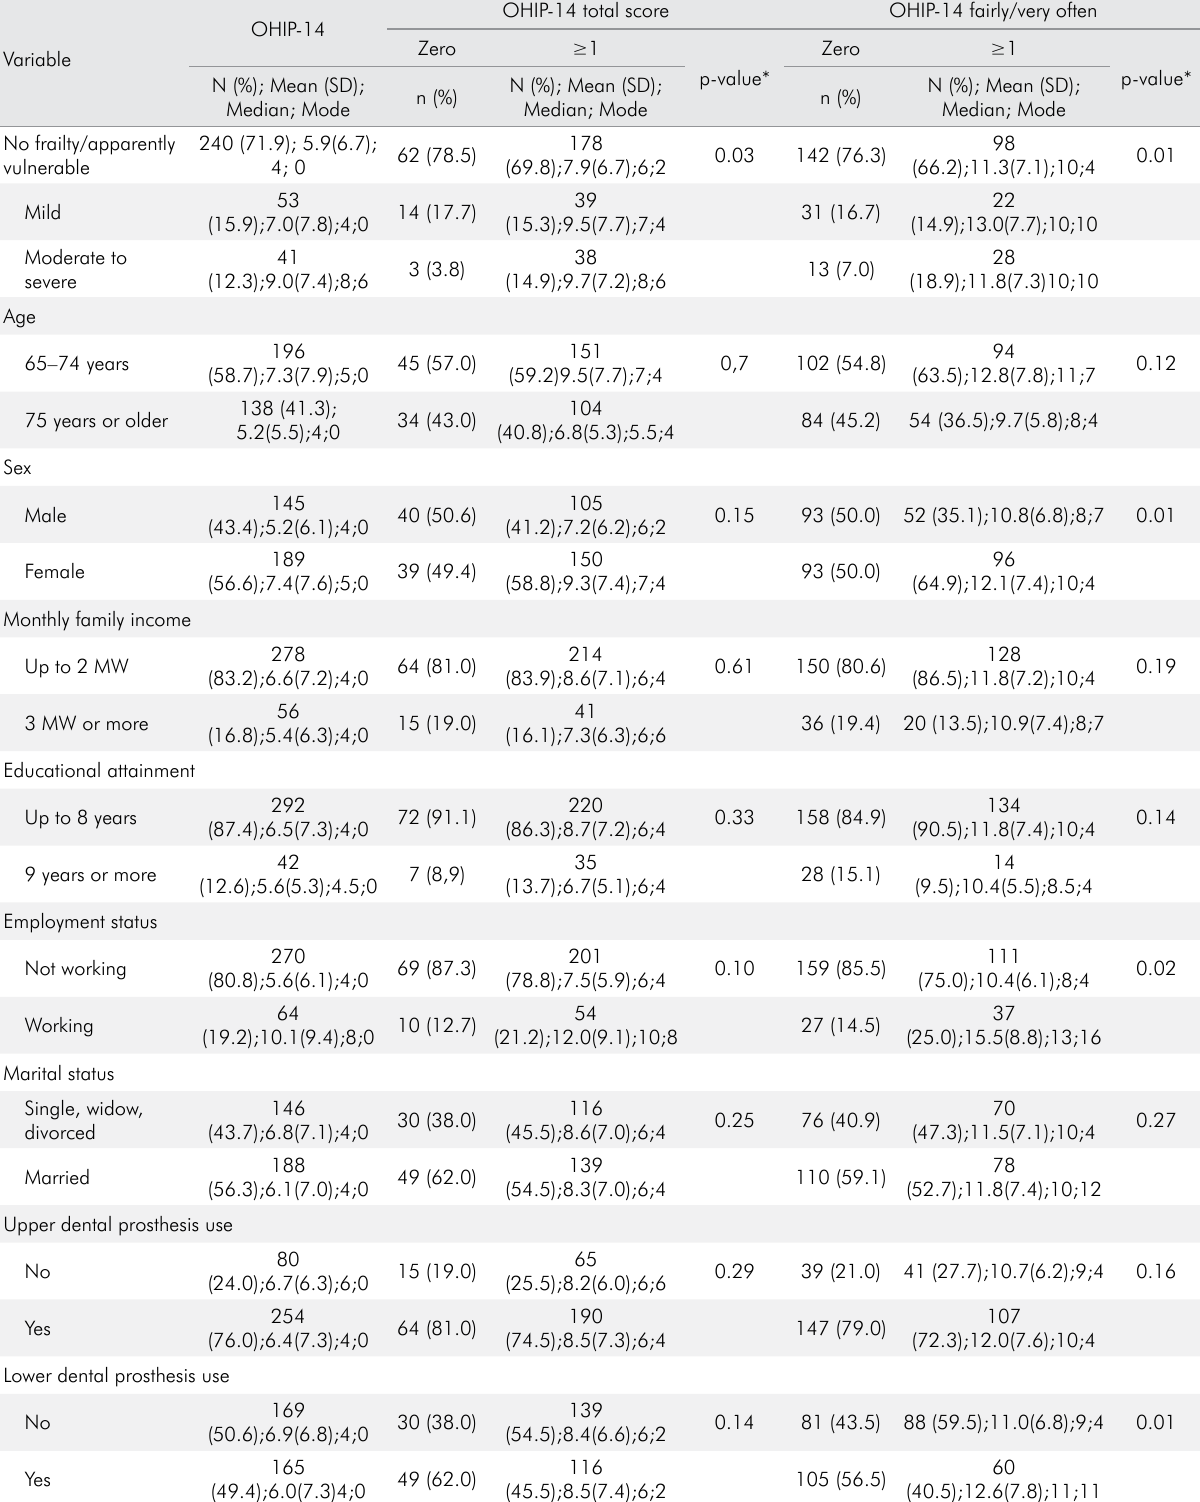
Table 1. Distribution of frailty, sociodemographic characteristics, dental clinical measures, and self-perceived dental care needs according to oral health-related quality of life outcomes among community-dwelling older